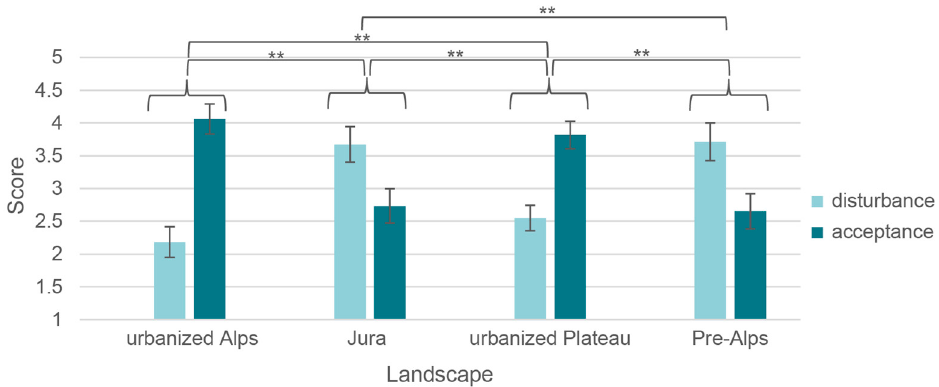
Figure 7. The degree of disturbance of power lines differs significantly between urbanized (Plateau/Alps) and near-natural landscapes (Jura, Pre-Alps).